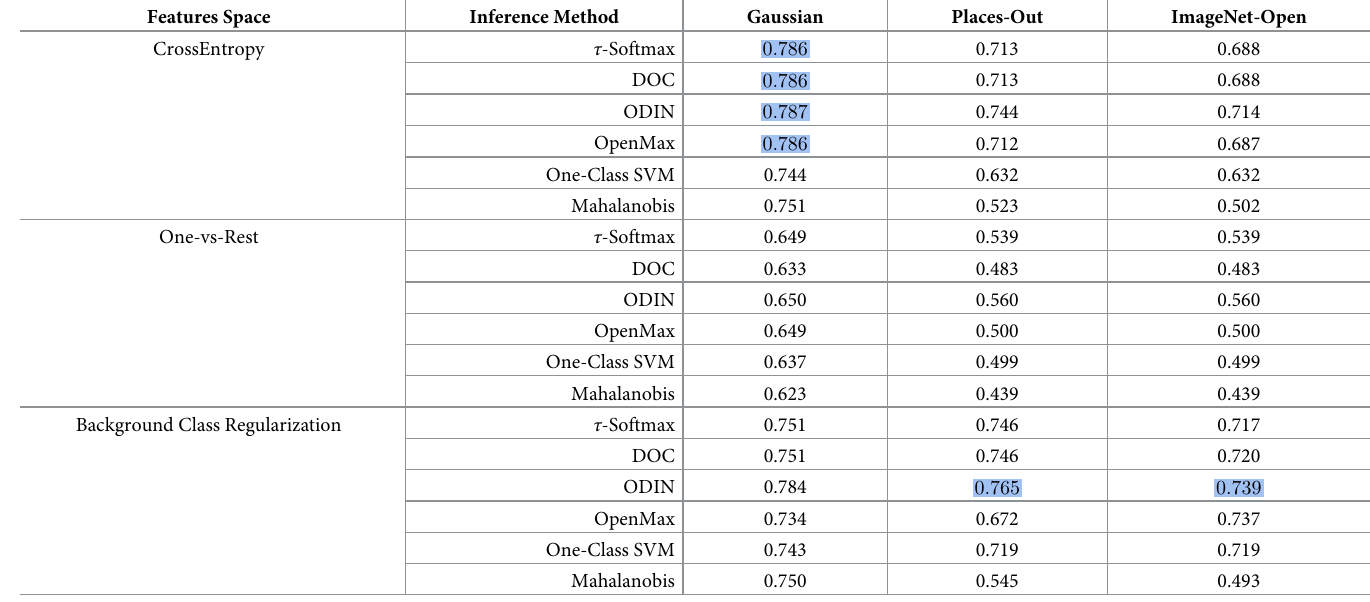
Table 2. Area Under the Open Set Classification curve (AUOSC) for outlier detection and open set classification performance in ImageNet trained models averaged over 5 runs. Top performer for each in-distribution / OOD combination is in blue along with statistically insignificant differences from the top performer as determined by DeLong’s test [62] ( α = 0.01 with a correction for multiple comparisons within each